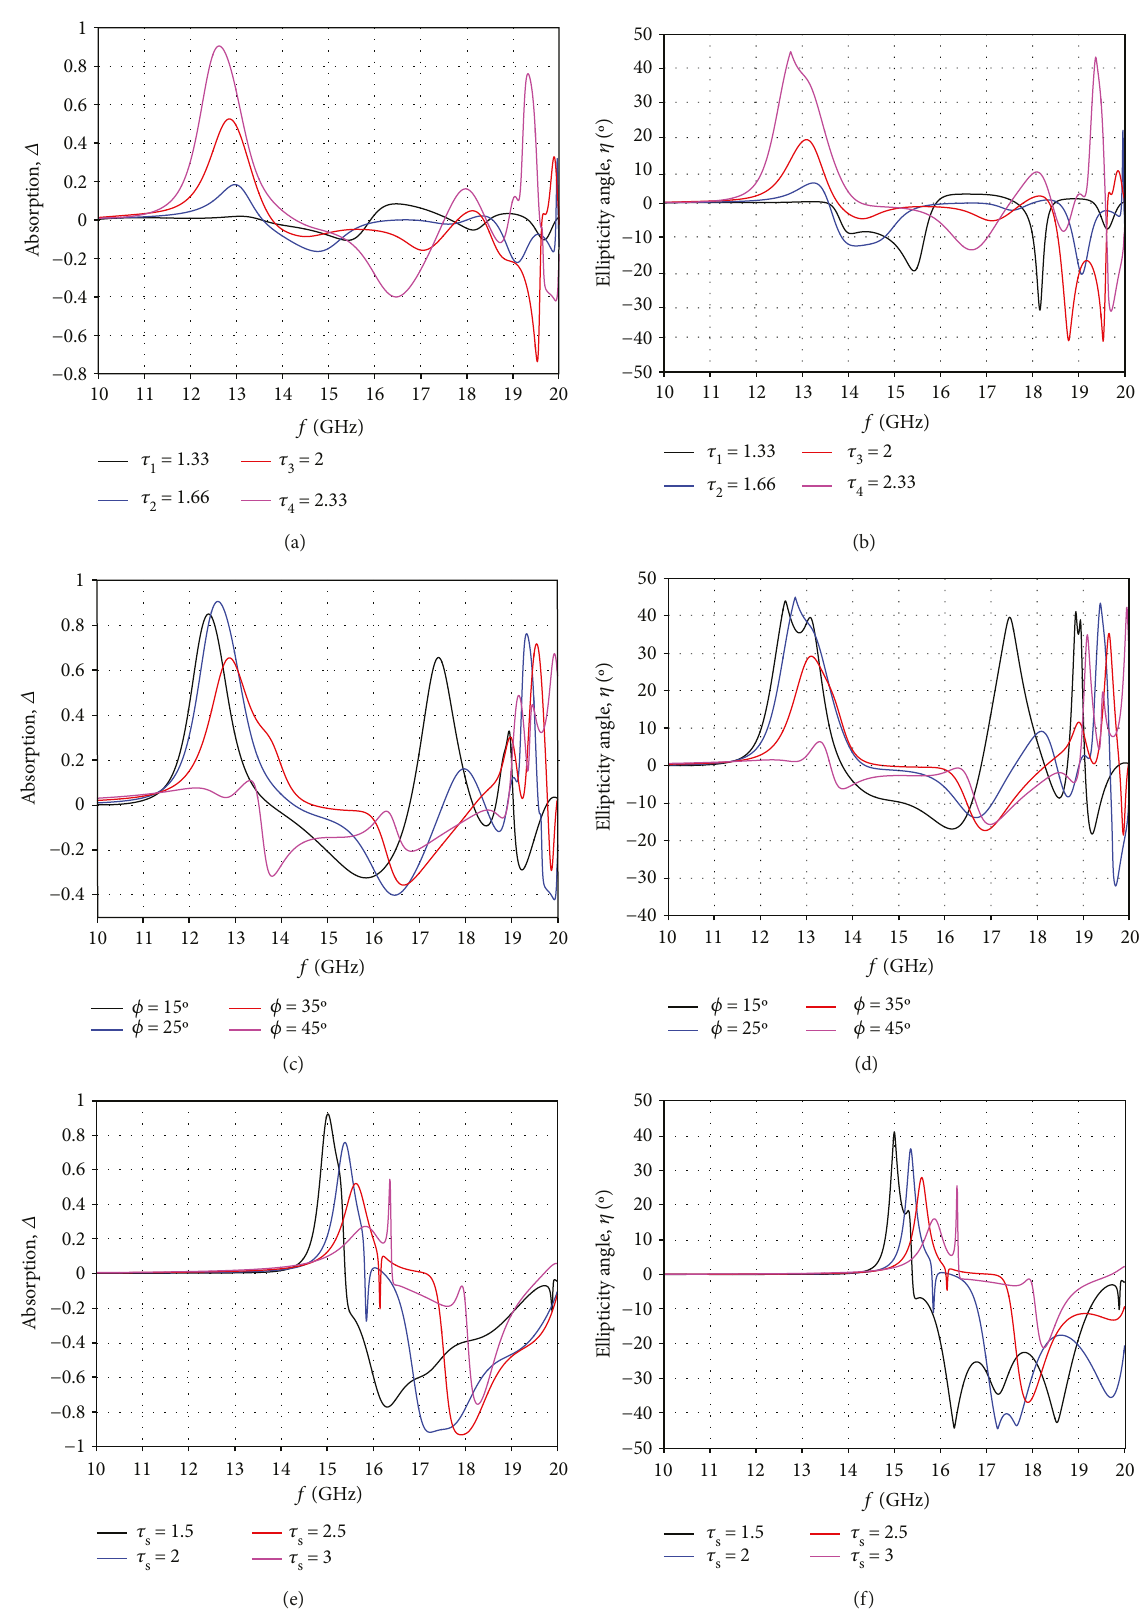
Figure 3: Variation of the absorption Δ and ellipticity angle η , over the frequency band 10 – 20GHz, for di ff erent values of the resonator ellipticity ((a) and (b)) and orientation ((c) and (d)) and the slot ellipticity ((e) and